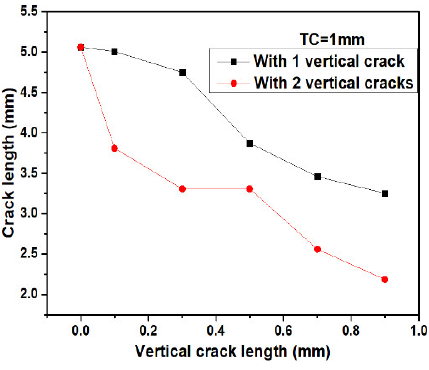
Figure 13. Plot of crack length as a function of depth of vertical pores for one vertical pore and two vertical pores.